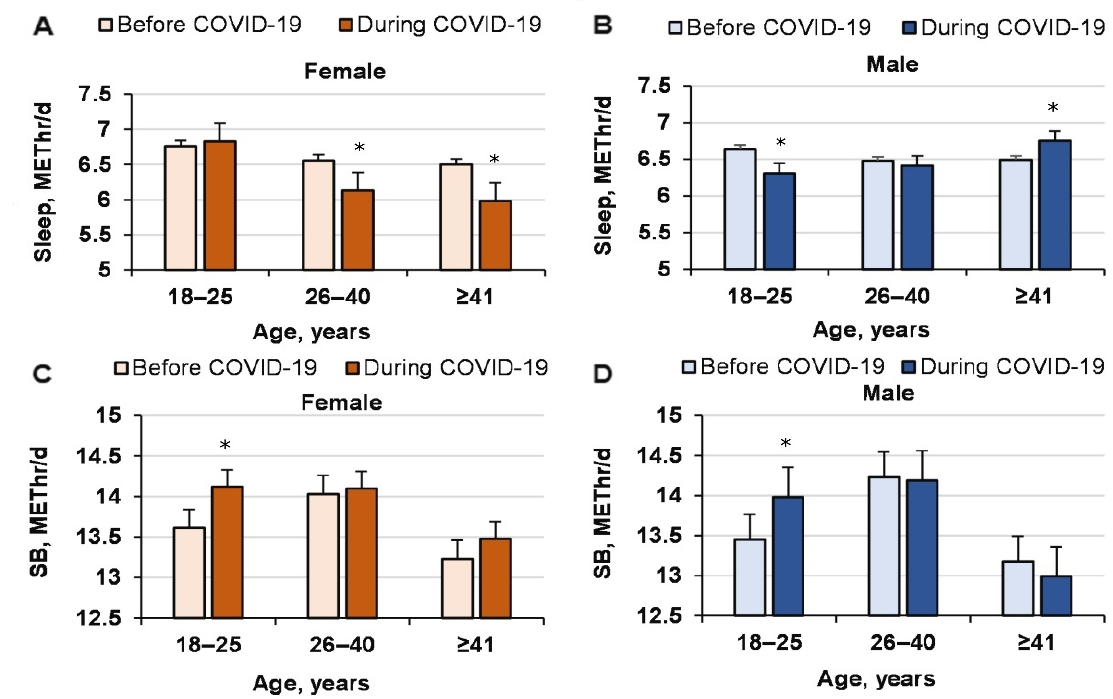
Figure 3. Sleep and sedentary behavior (SB) METs before and during COVID-19 for men and women of different ages. * compared to before COVID-19.